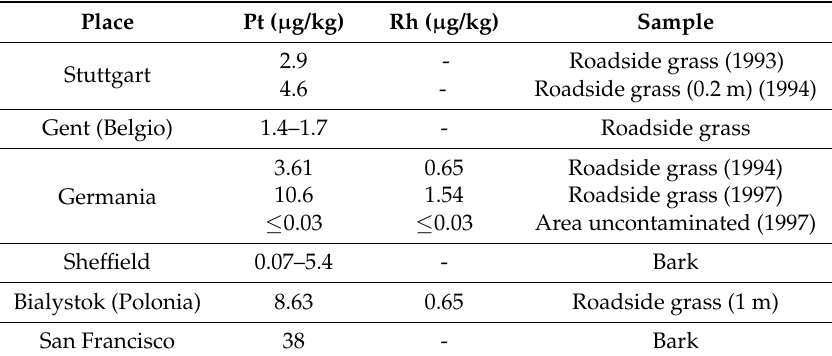
Table 4. Platinum and rhodium concentrations in environmental matrices [26].